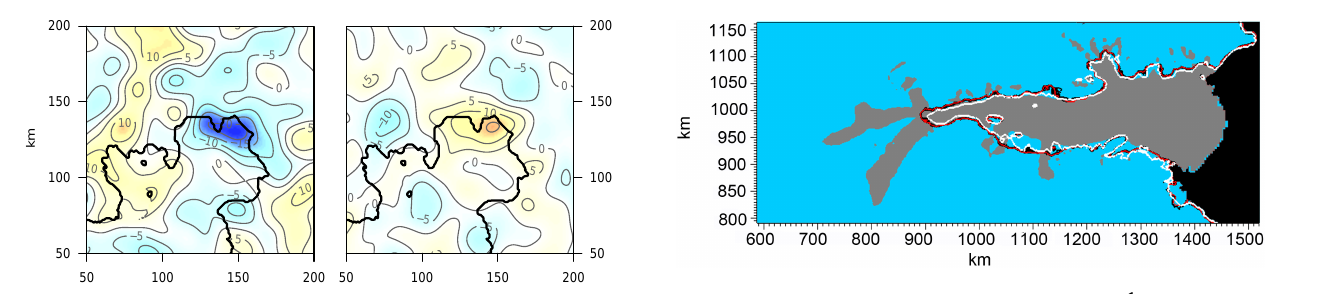
Figure 8. Region where ice velocity >100myr − 1 (grey) for the Lambert–Amery Basin (the boxed region in Fig. 2b). The location of grounding lines (first simulation year in white, last in black) in each of the 50 realizations of the low-frequency noise experiments is shown. The noiseless experiment (red contour) results are close to the other experiments but retreat more in the fast-flowing